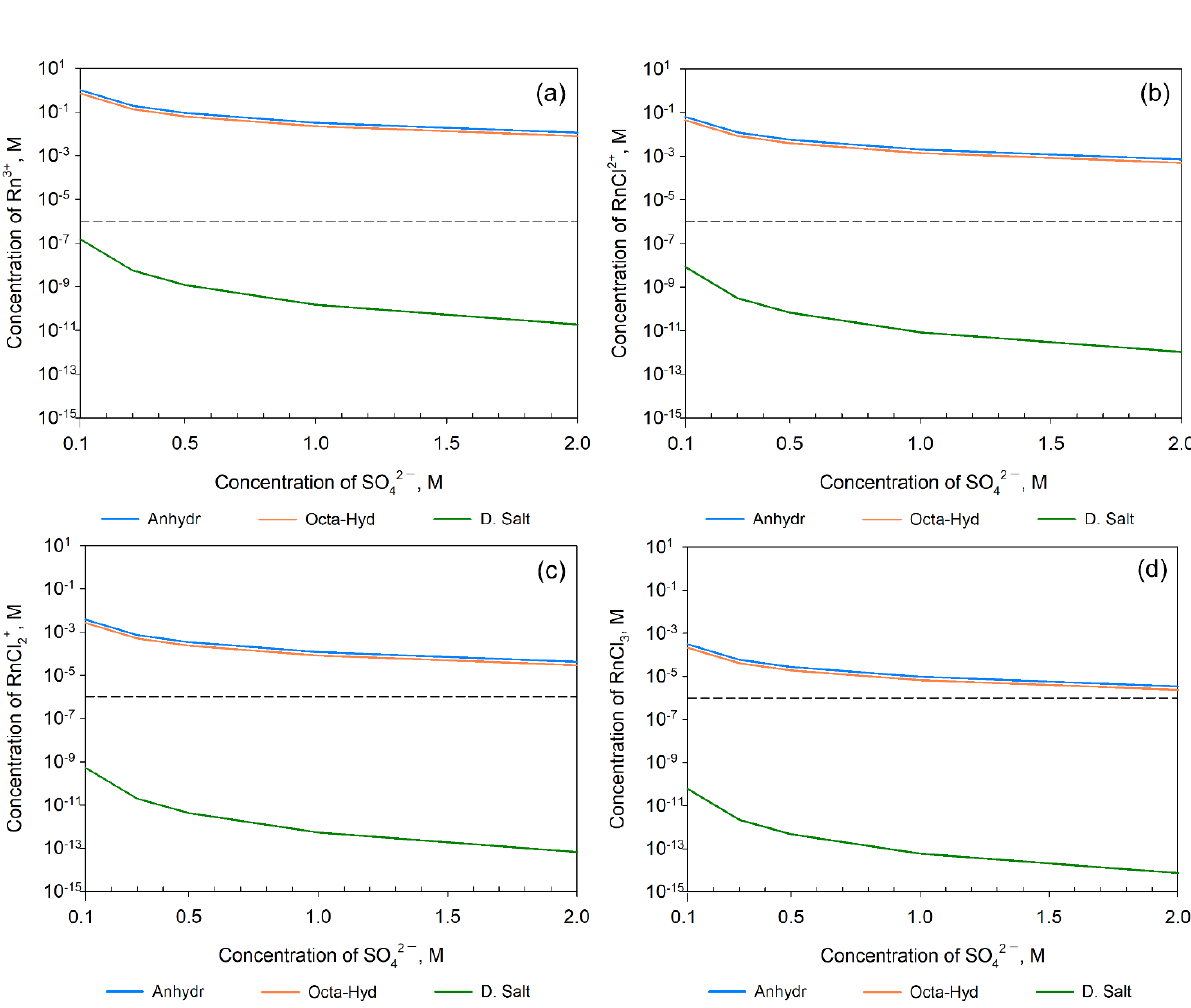
Figure 5. Graphical presentation of precipitation of Rn 3+ , RnCl 2+ , RnCl 2+ , and RnCl 3 into three sulfates, anhydrous, octa-hydrated, and sodium double salt at pH 3 with HCl (dashed line: 1 ppm). ( a ) Rn 3+ precipitates into the three products. ( b ) RnCl 2+ precipitates into the three products. ( c ) RnCl 2+ precipitates into the three products. ( d ) RnCl 3 precipitates into the three products. Table 3. Average concentration of Rn 3+ from the ten REEs selected when the concentration of sulfate or bisulfate is 1 mol/L in equilibrium with three sulfate precipitates at pH 1 and 3 with HCl. Concentration ratio at pH 1 to pH 3 are also